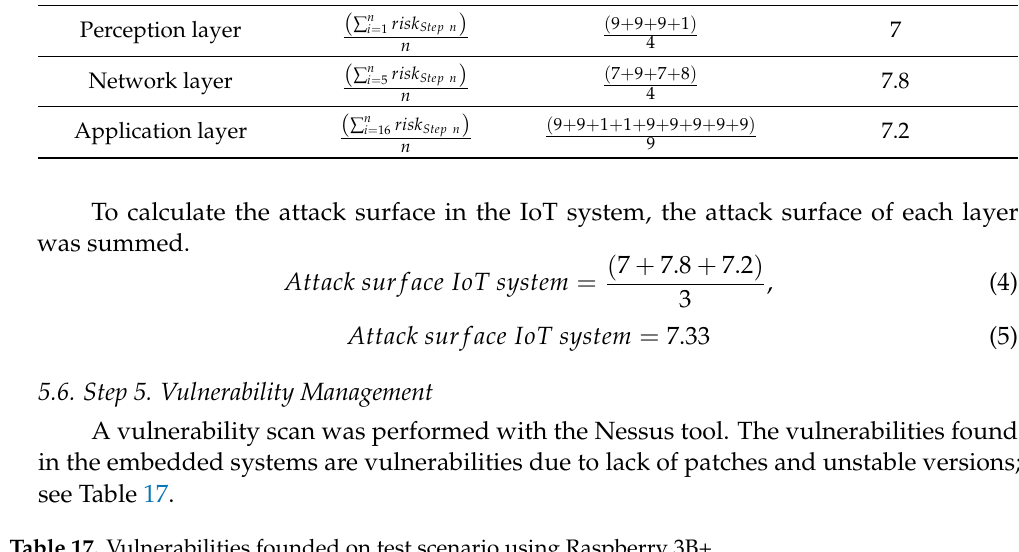
Table 17. Vulnerabilities founded on test scenario using Raspberry